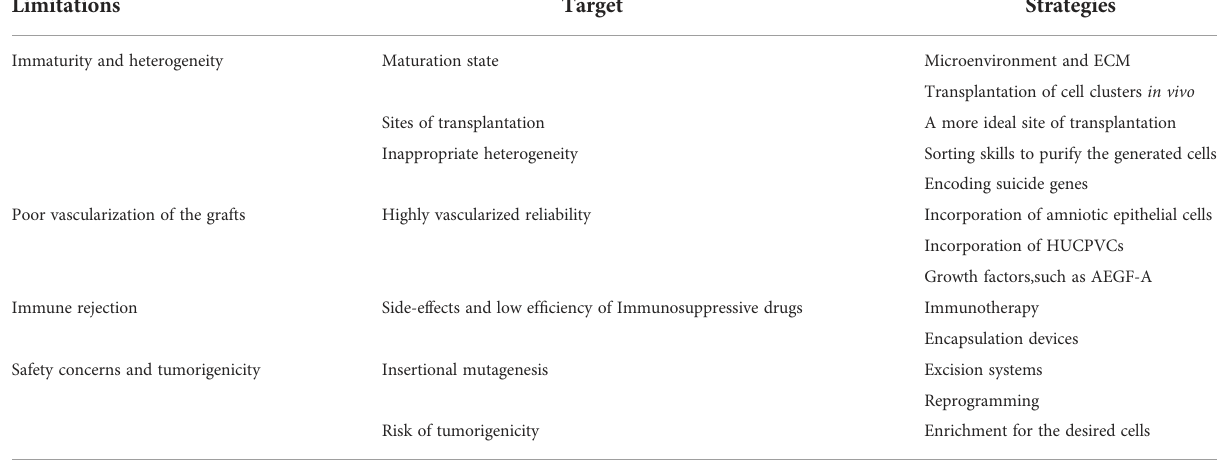
TABLE 3 Limitations and strategies for stem cells therapy in